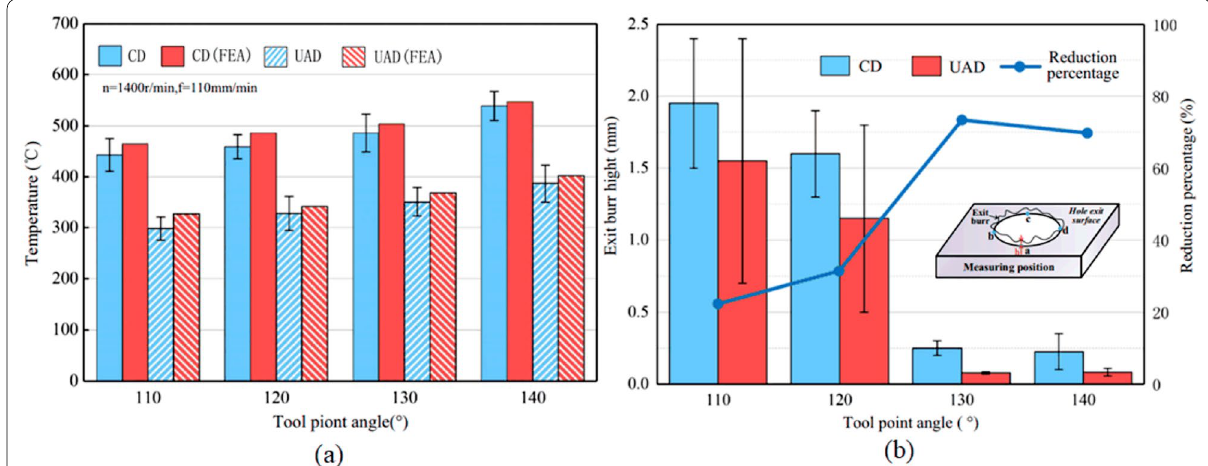
Figure 18 Influence of point Angle on drilling temperature and burr height: a comparison of cutting heat between CD and UAD, b comparison of exit burr height and reduction percentage between CD and UAD